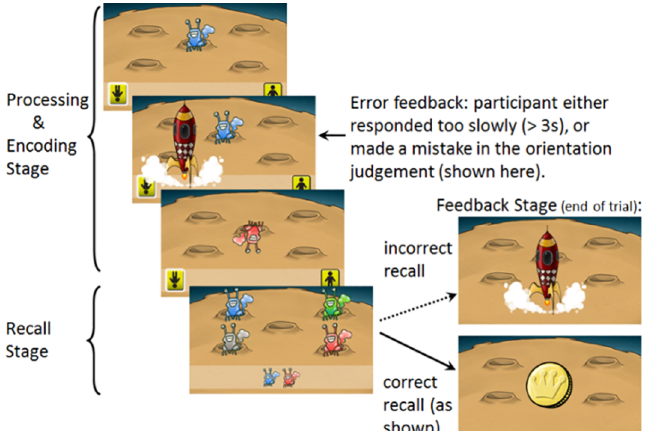
Figure 2. Domain-general condition: Working memory training. Example for set size 2, along with feedback screens shown at the end of each